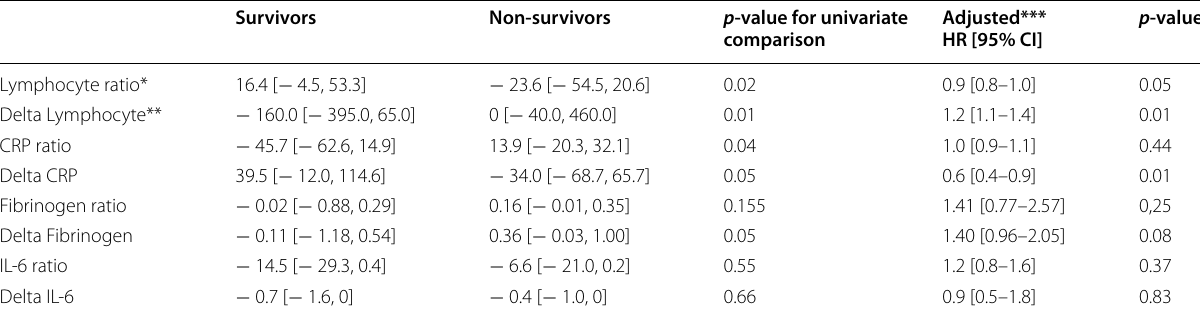
Table 3 Relationship between biomarkers variations between Day 0 and Day 3–4 and the outcome